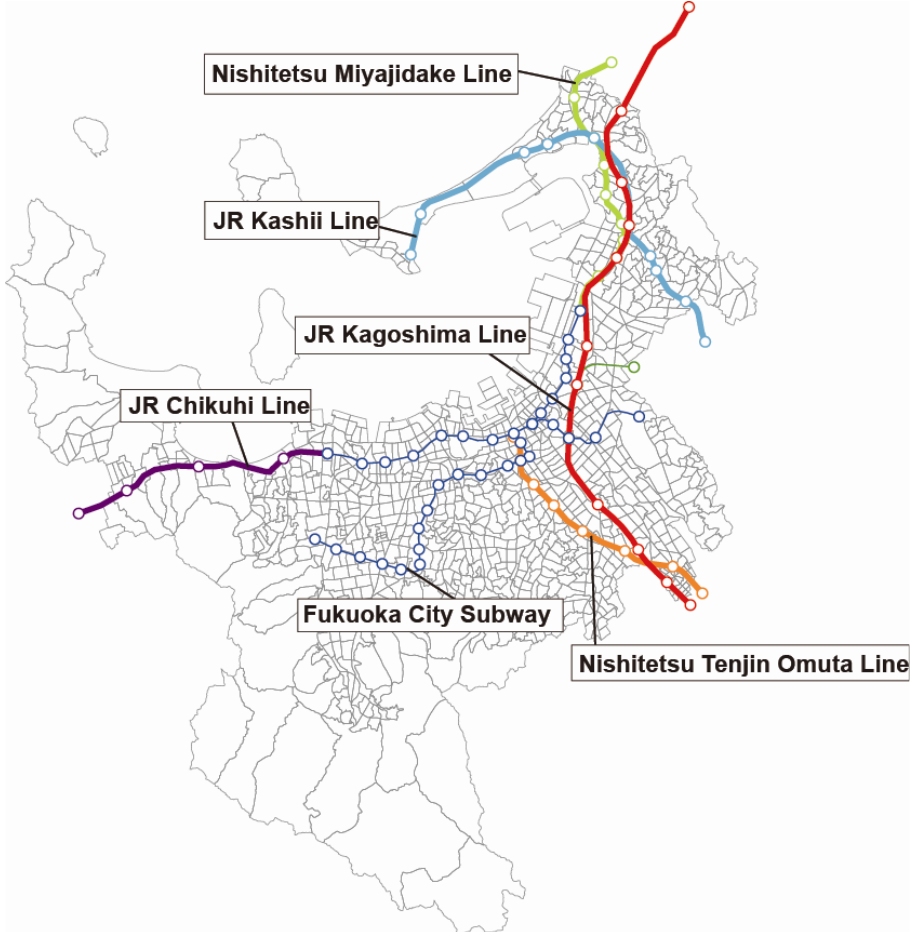
Figure 2. Overview of rail transit lines in Fukuoka, Japan.